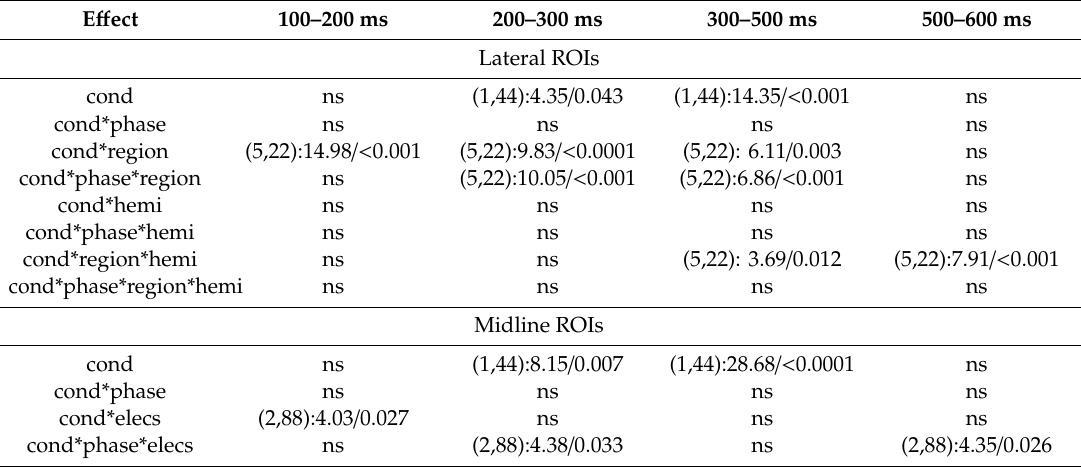
Figure 3. Event-related brain potentials (ERP) results. ( A ) Grand averages for the preparation phase. ( B ) Grand averages for the execution phase. Negative polarity is plotted upward. Table 1. Electroencephalography (EEG) results of the repeated measure ANOVAs for all time windows.